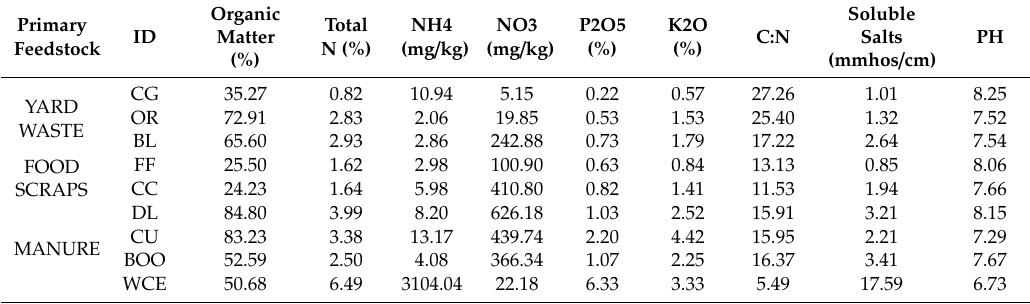
Table 6. Results of tested composts. BL and CC composts fall within recommended ranges in every category and would therefore be recommended by the authors for urban soil